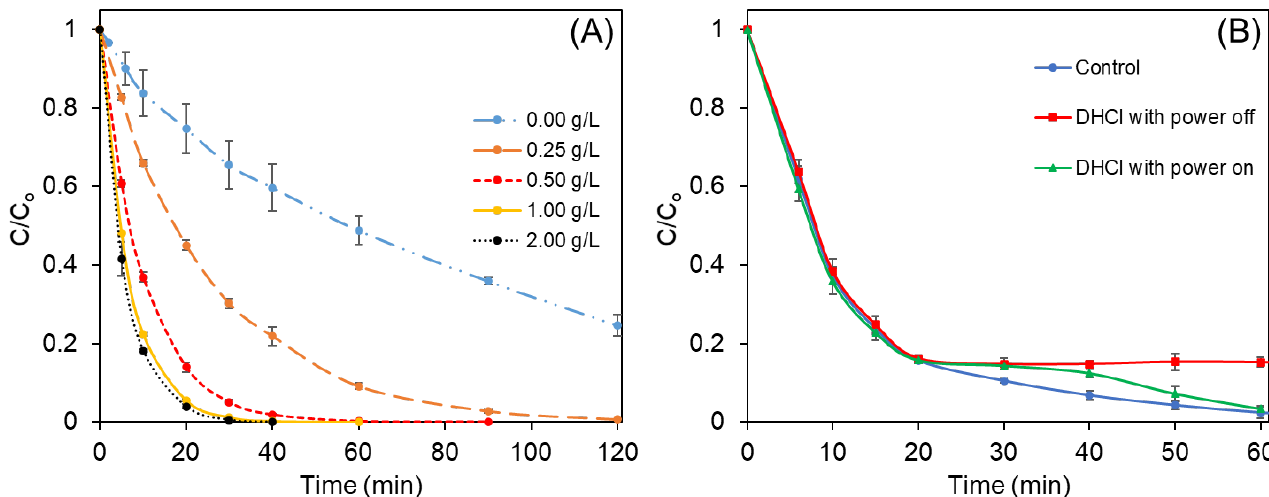
Figure 3. ( A ) Influence of NaCl concentration in 0.17 M Na 2 SO 4 aqueous solution on the electrochemical degradation of MB (50 mg/L) on the Ni 0.6 Co 0.4 -oxide anode at 20 mA/cm 2 ; ( B ) Effect of addition of 40 mM dopamine hydrochloride into the electrolyte at the 20 th minute on the kinetics of degradation of MB at 10 mA/cm 2 in the case when the current supply to the cell was and was not terminated. In the control experiment, no dopamine hydrochloride was present in the electrolyte, but the current supply to the cell was terminated at the 20th minute.